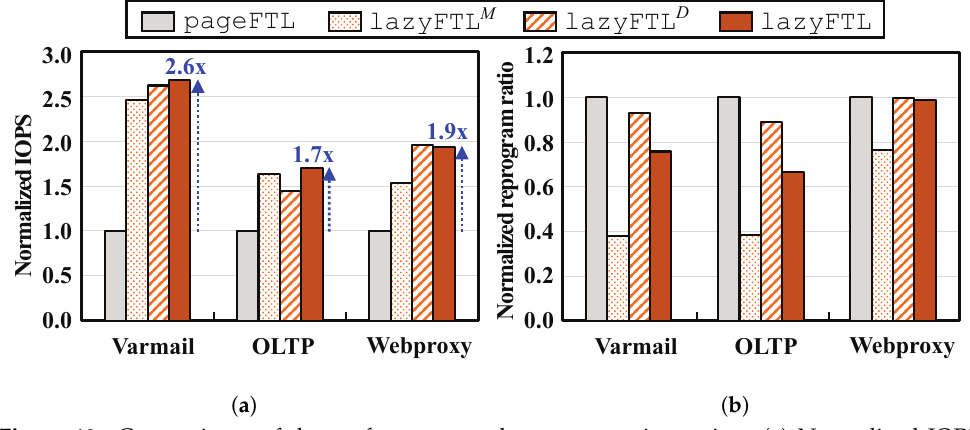
Figure 10. Comparisons of the performance and reprogramming ratios. ( a ) Normalized IOPS. ( b ) Normalized reprogramming